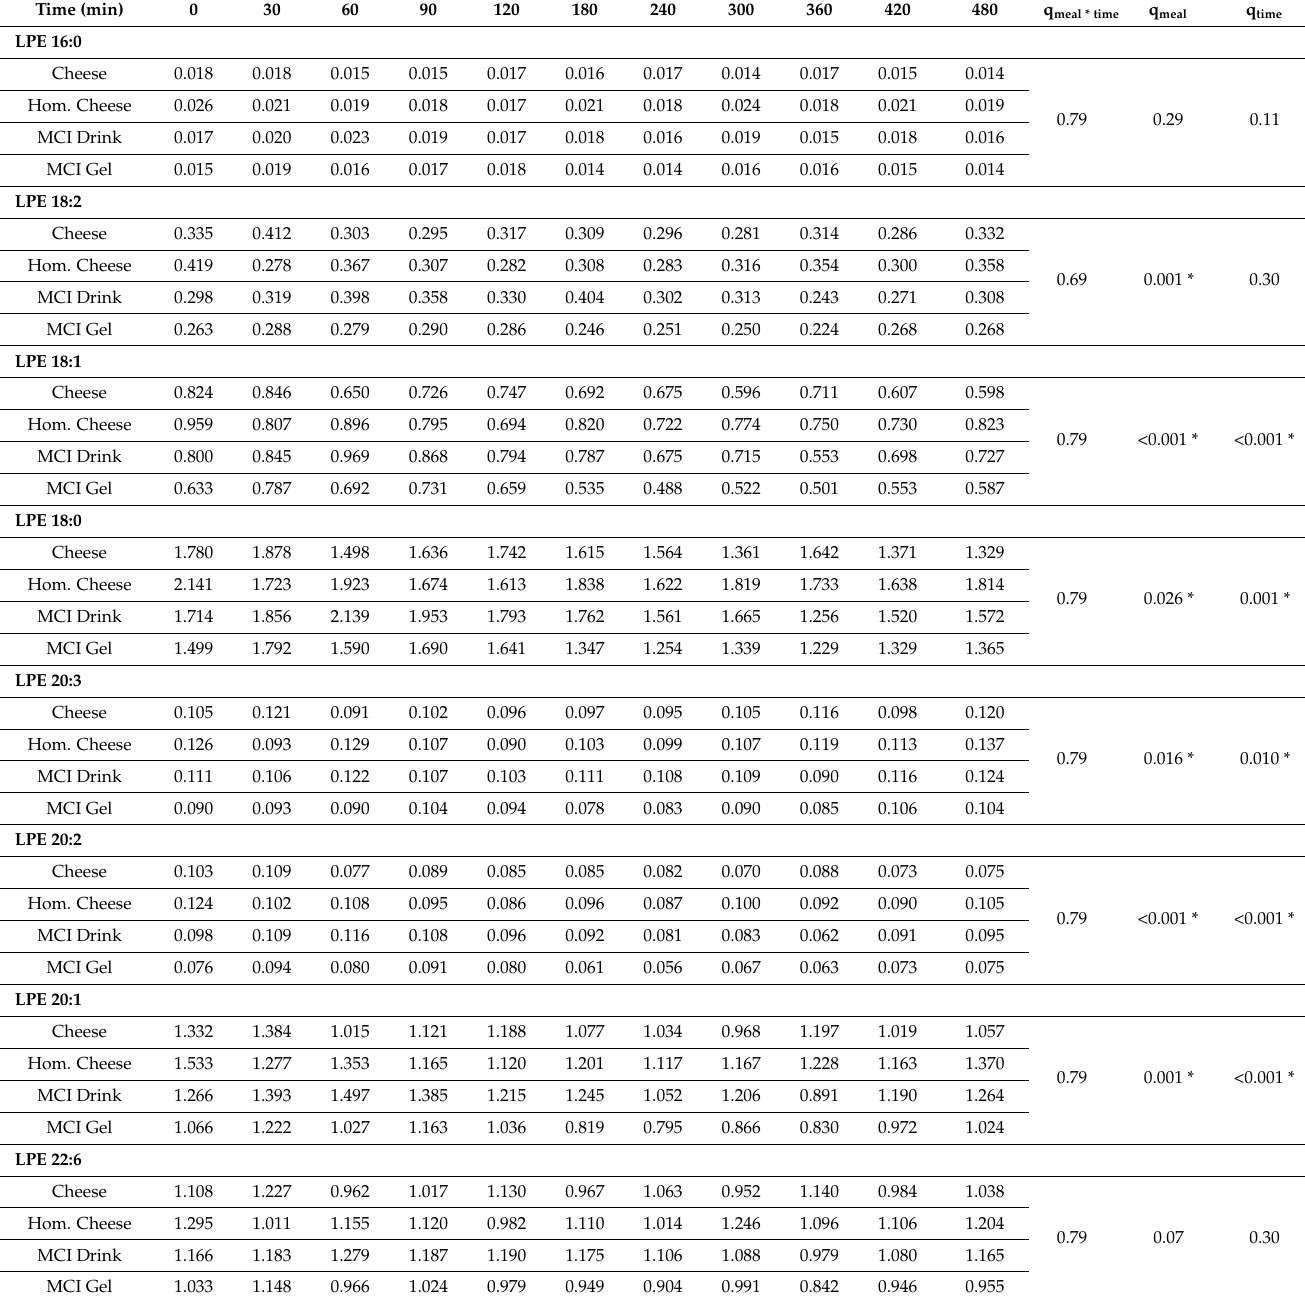
Table 1. Relative level of lysophosphatidylethanolamine (LPE) in plasma samples.* Data were analyzed by repeated measures using a linear mixed model. Overall participant and within-visit participant differences were included as random factors and the analyses were adjusted for BMI, age and visit. q -values indicate FDR-adjusted p -values for meal–time interactions (q meal * time ), the effect of meal (q meal ) and the effect of time (q time ). * indicate significant differences ( q <